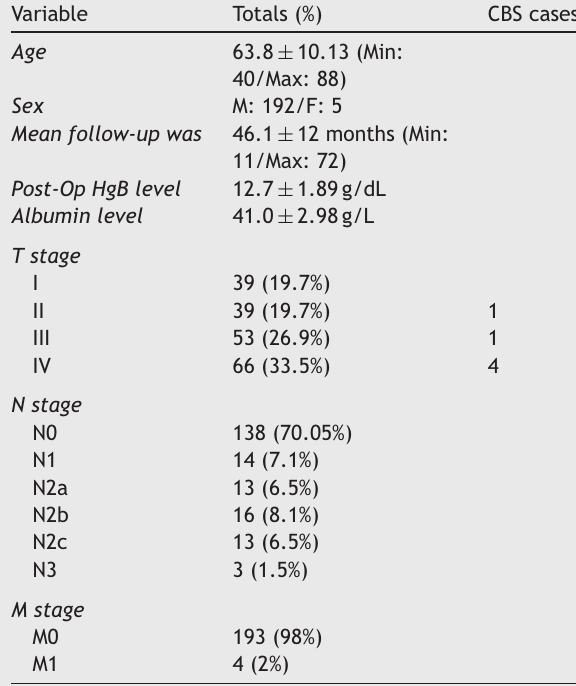
Demographic data of patients with larynx cancer with and without carotid blowout.